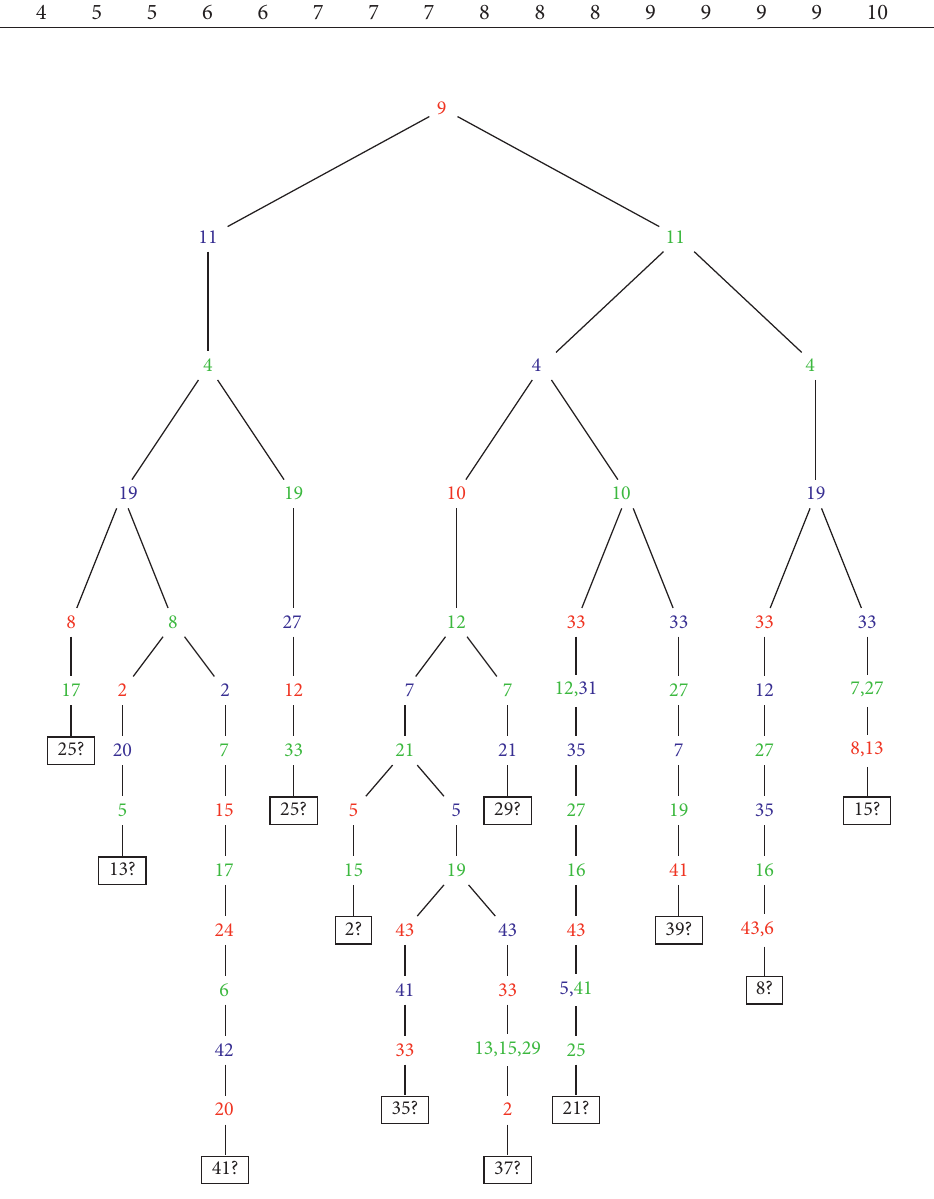
Figure 1: Tree representation for χ ( 9 ) �